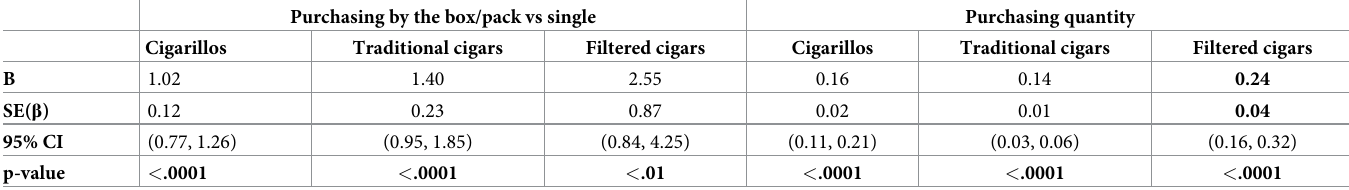
Table 2. The association between cigar purchase patterns (by the box vs single and quantity) and the average number of cigars smoked per